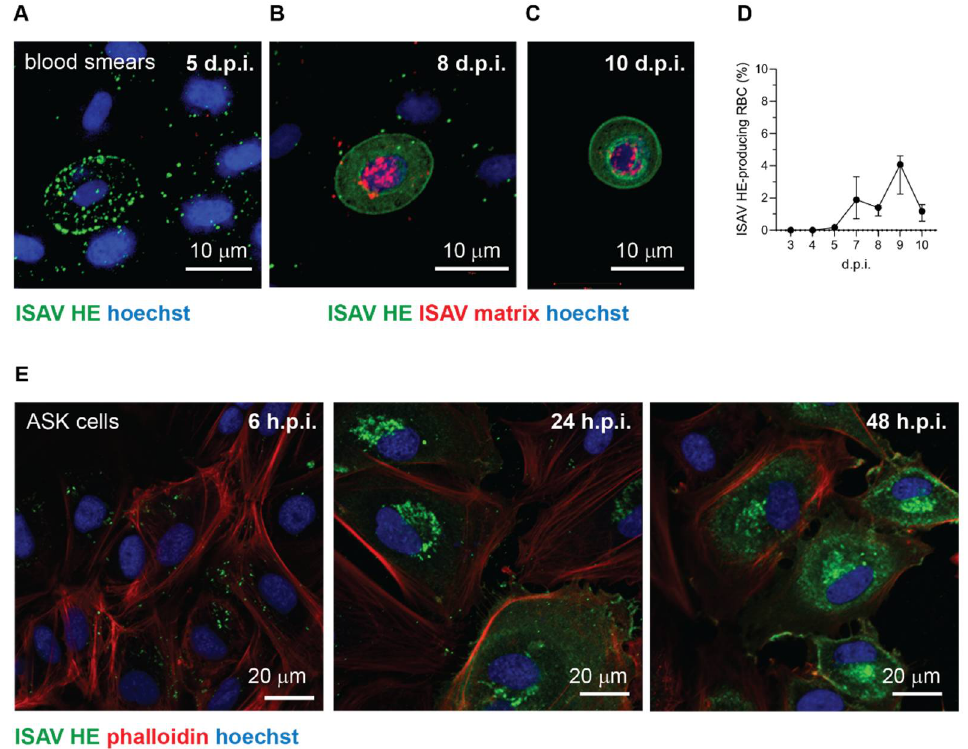
Figure 5. Occasionally, a subset of erythrocytes in infected Atlantic salmon express ISAV proteins. ( A – C ) Confocal micrographs of immunostained blood smears from ISAV-infected fish in the 2018 trial. ( A ) Example of the most frequently observed pattern with extensive coating of erythrocytes with HE-positive particles. ( B , C ) Examples of the few erythrocytes ( B ) and rare rounded erythrocyte-like cells ( C ) that express ISAV HE and matrix proteins. Images show maximum intensity projections from z-stacks. ( D ) Percentage of HE-expressing erythrocytes in the 2018 trial. The graph shows medians (dots) and 95% confidence intervals (bars) calculated from manual counts of 10 microscope fields, 3 fish per time point. ( E ) Confocal micrographs of immunostained ISAV-infected ASK cells illustrate the typical change in signal pattern as the infectious cycle progresses. In the initial stage of infection, staining reveals a bright punctuate pattern (left panel). Once cells start to express ISAV HE protein, a bright perinuclear signal appears in the region of the Golgi apparatus (middle panel). Finally, extensive cytoplasmic and membrane staining is present in the late stage of infection (right panel). Images in panel E were obtained in a single z plane.